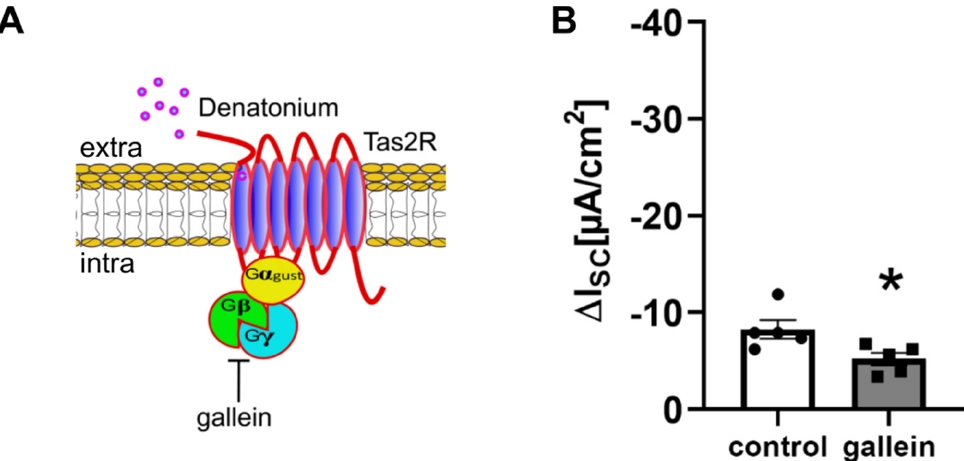
Figure 2. Denatonium acts on G protein-coupled taste receptors. ( A ) Schematic drawing of the action of the G βγ inhibitor gallein. ( B ) The G βγ subunit antagonist gallein (50 µM, n = 5, apical) reduced the denatonium-induced current ( ∆ I SC , n = 5, * p < 0.05).